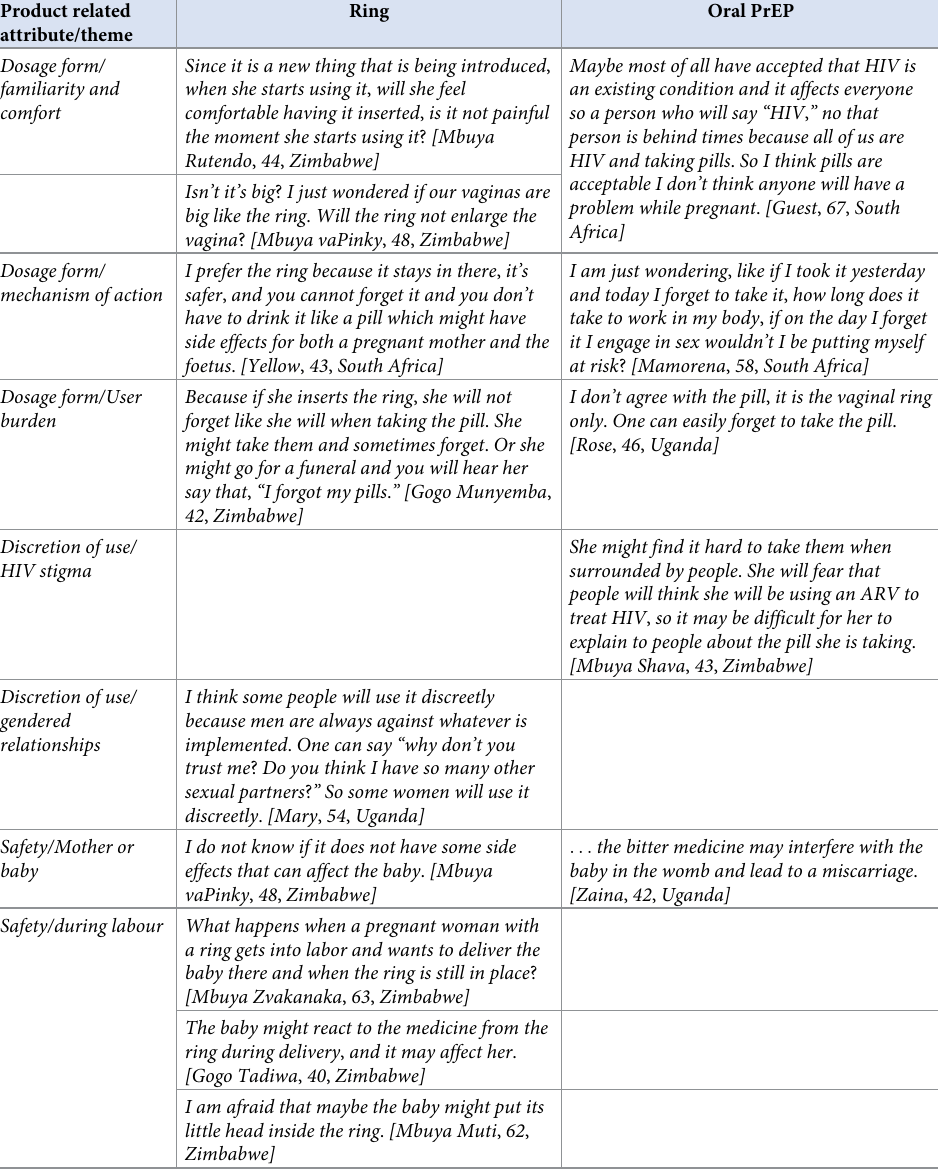
Table 4. Grandmother views on the ring and oral PrEP for pregnant and breastfeeding